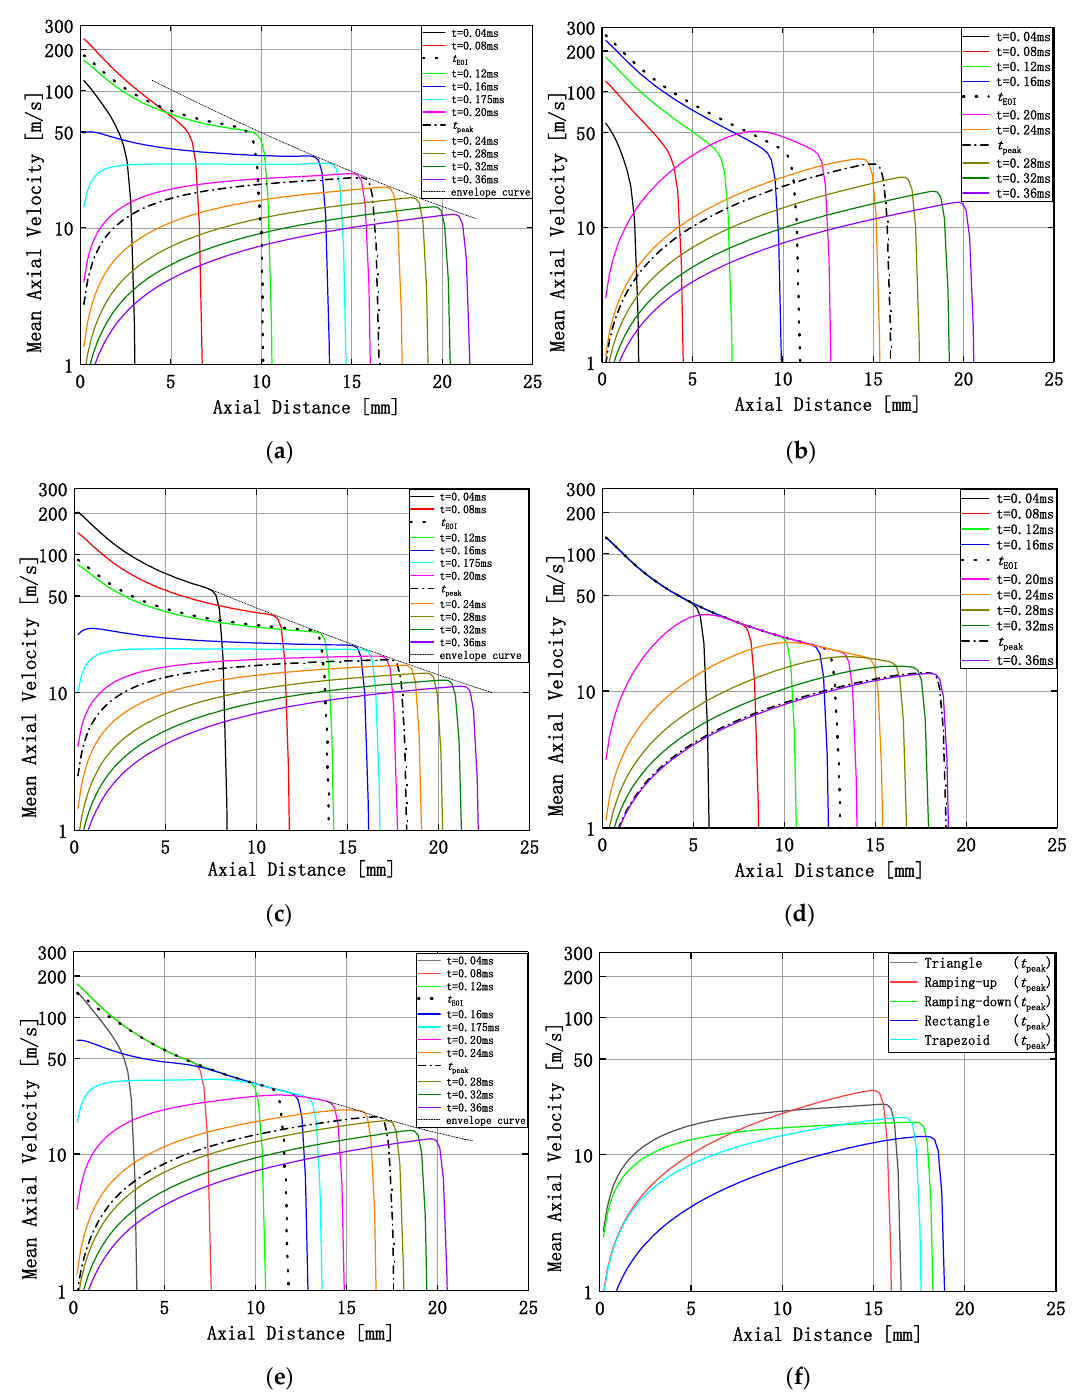
Figure 7. Mean axial velocity under five injection rate shapes: ( a ) Triangle; ( b ) Ramping-up; ( c ) Ramping-down; ( d ) Rectangle; ( e ) Trapezoid and ( f ) Comparison at t peak .